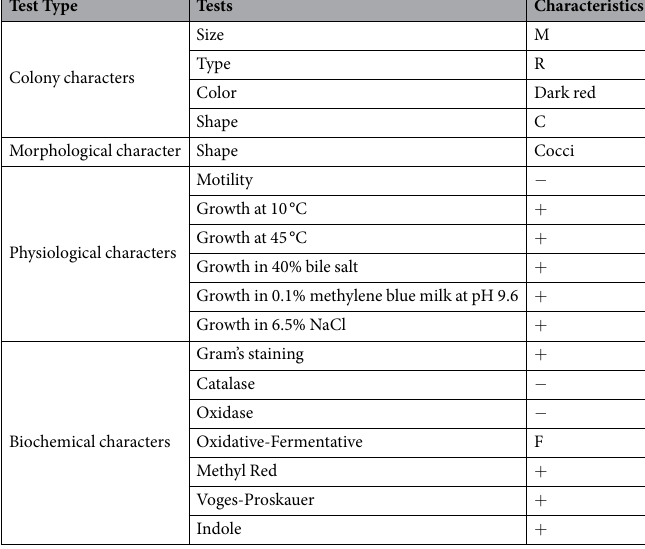
Table 1. Morphological, physiological and biochemical characters of 48 E . faecalis isolates collected from infected fishes in Bangladesh. M: medium; R: round; C = convex; F: Fermentative; + : positive; − :